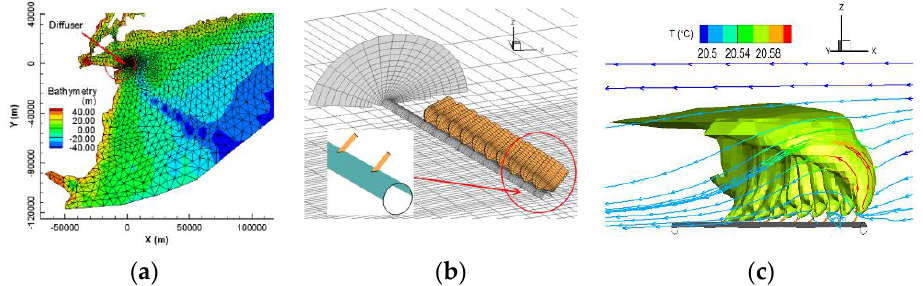
Figure 2. Simulation of thermal effluents discharged from a diffuser on seabed by coupling of a Navier–Stokes solver and FVCOM [16,48]. In the simulation, the former resolves local flows, and the latter captures the background currents, and the two models are coupled in two-way and march in time simultaneously. ( a ) Mesh of FVCOM. ( b ) Mesh of the Navier–Stokes equations solver. ( c ) Simulated thermal effluent at flood tide.